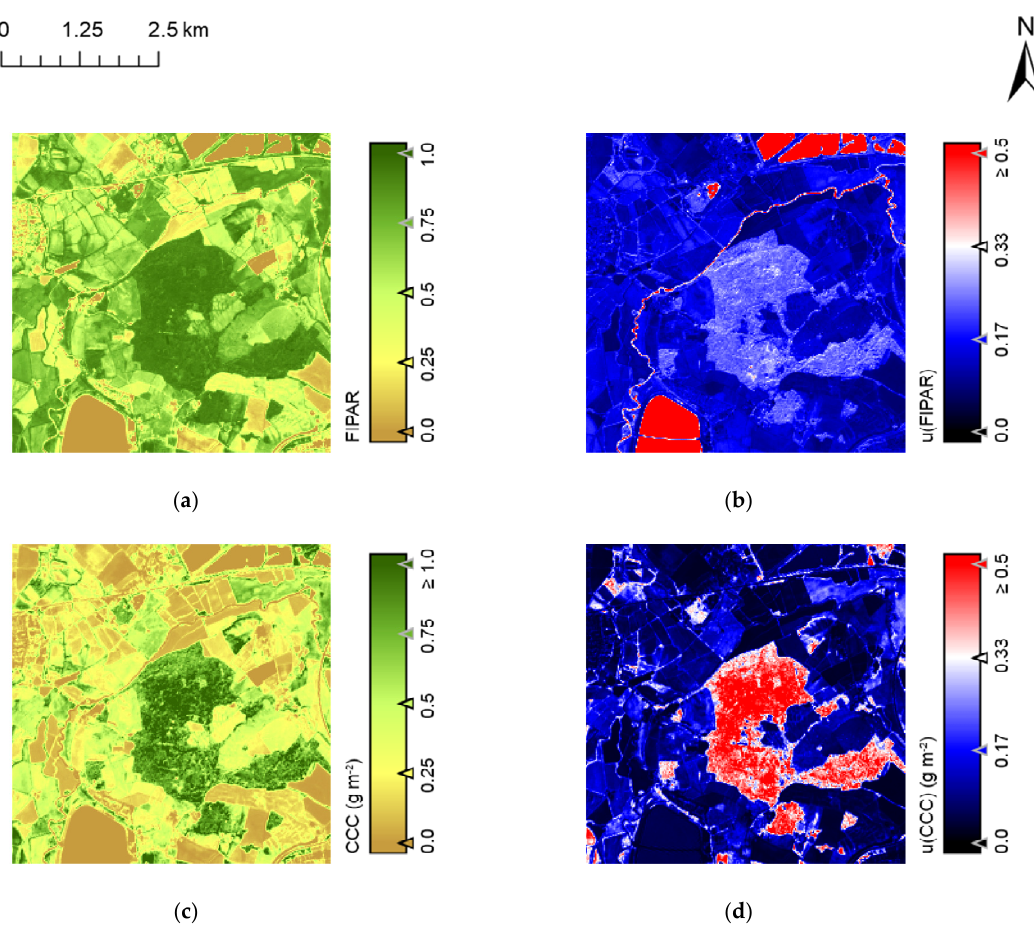
Figure 9. High-spatial-resolution maps ( left ) and per-pixel standard uncertainties ( right ) of FIPAR ( a , b ) and CCC ( c , d ) from the Wytham Woods campaign.